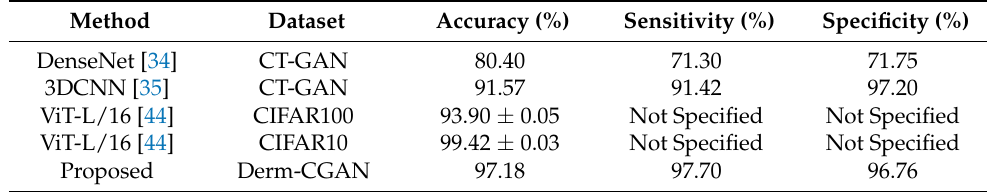
Table 5. Comparative study on similar Datasets and Detection Model